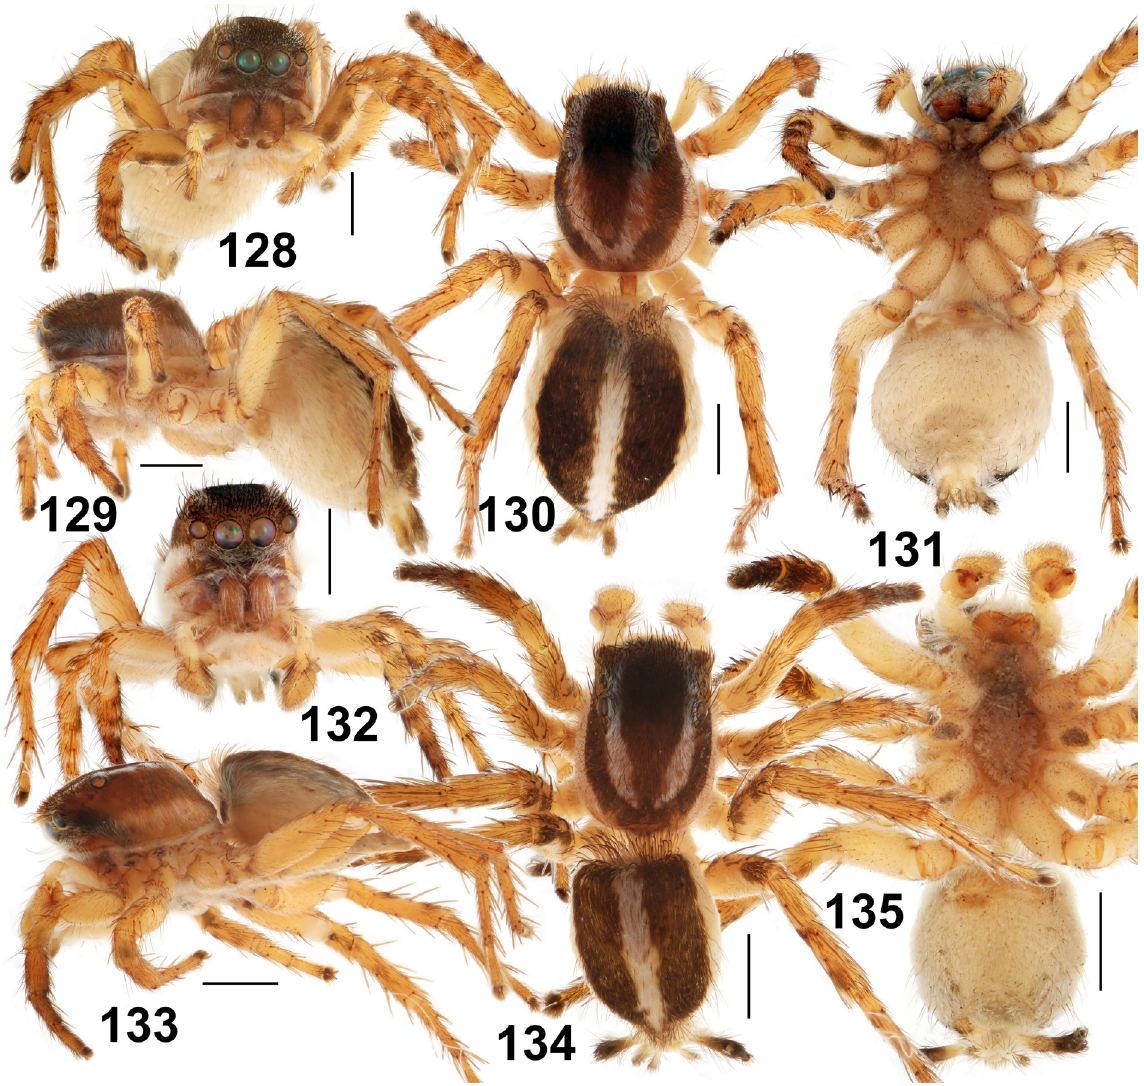
Figs 128–135. Stenaelurillus furcatus Wesołowska, 2014 from Namibia (Etosha National Park; MRAC 215.642), general appearance. 128–131 . ♀. 132–135 . ♂. Scale bars: 1